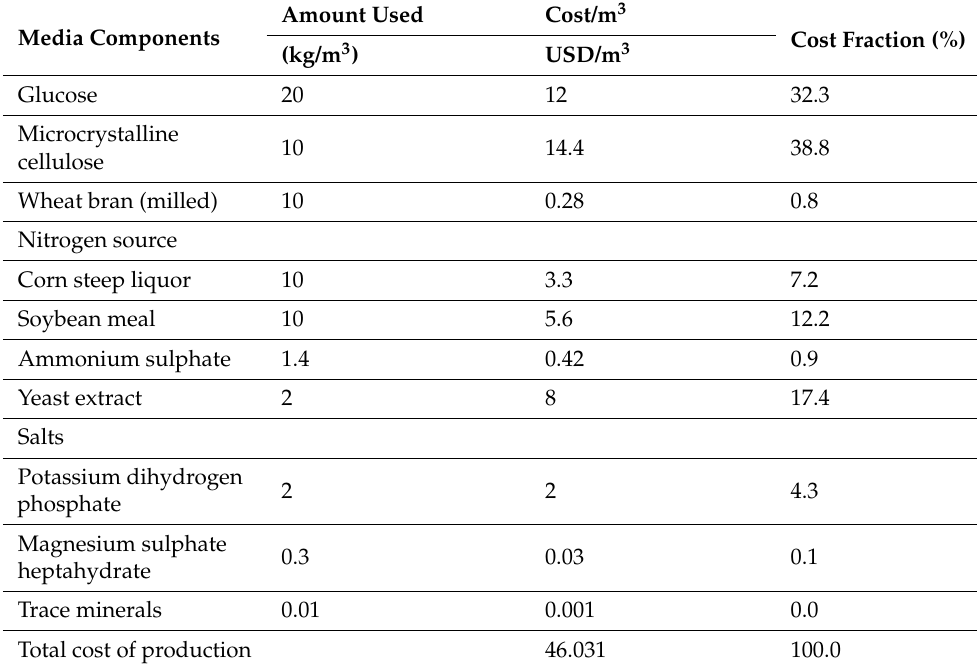
Table 3. List of media components used in the cellulase production media.